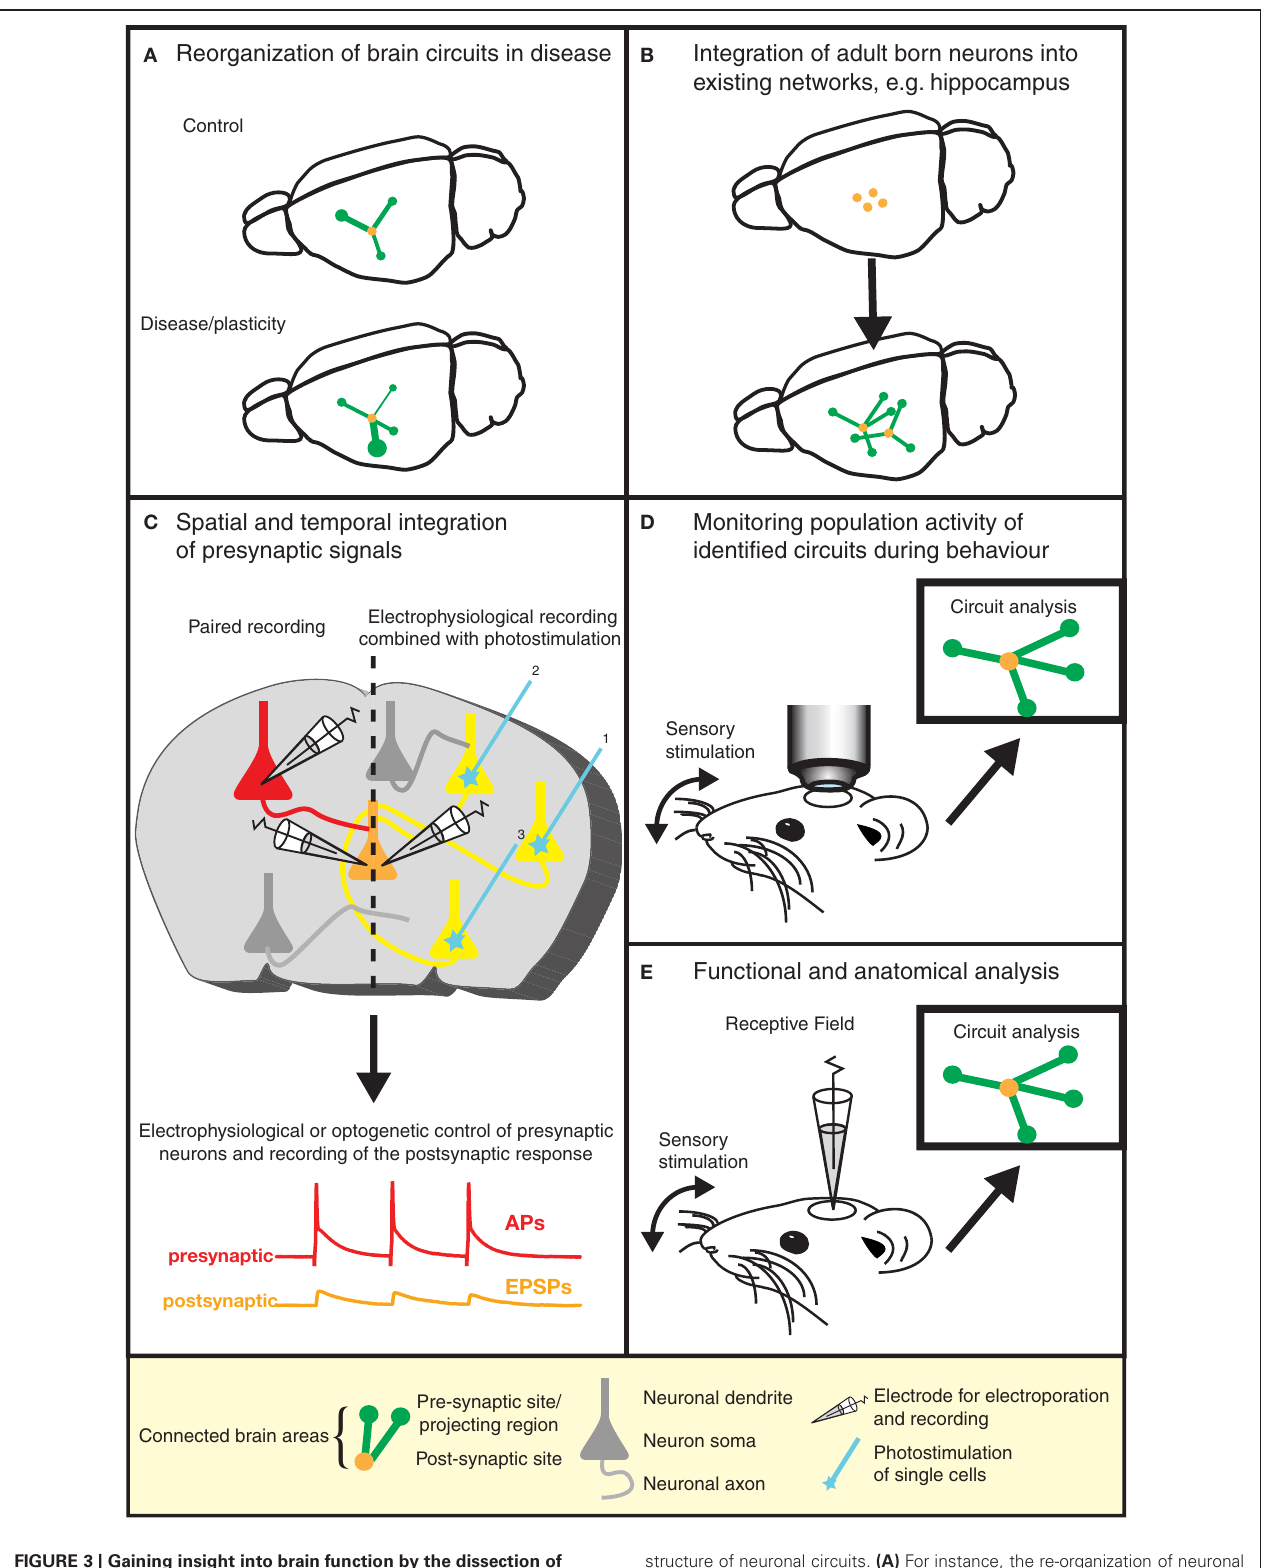
FIGURE 3 | Gaining insight into brain function by the dissection of neuronal circuits. Recent advances in RABV (cid:2) G technology provide invaluable tools for gaining a better understanding of the function and